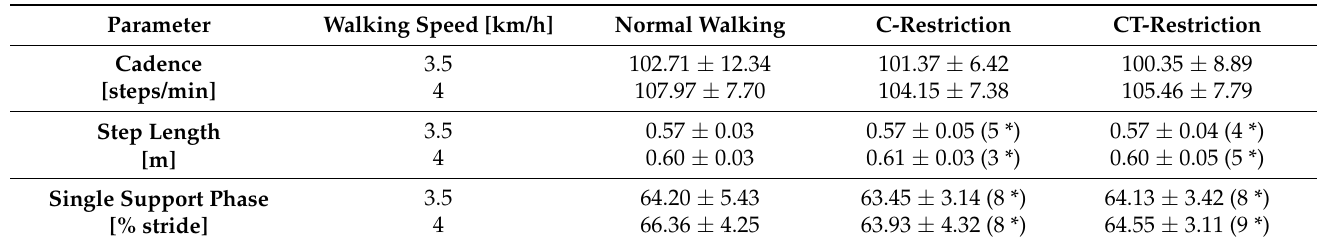
Table 1. Gait timing between subjects. Median ± IQR among subjects. The step length was normalized to the subject height. The information in parentheses indicates the number of subjects that experienced a significant reduction in the respective gait parameter. * p < 0.05 indicates a significant reduction in comparison with normal walking. Parameter Walking Speed [km/h] Normal Walking C-Restriction CT-Restriction